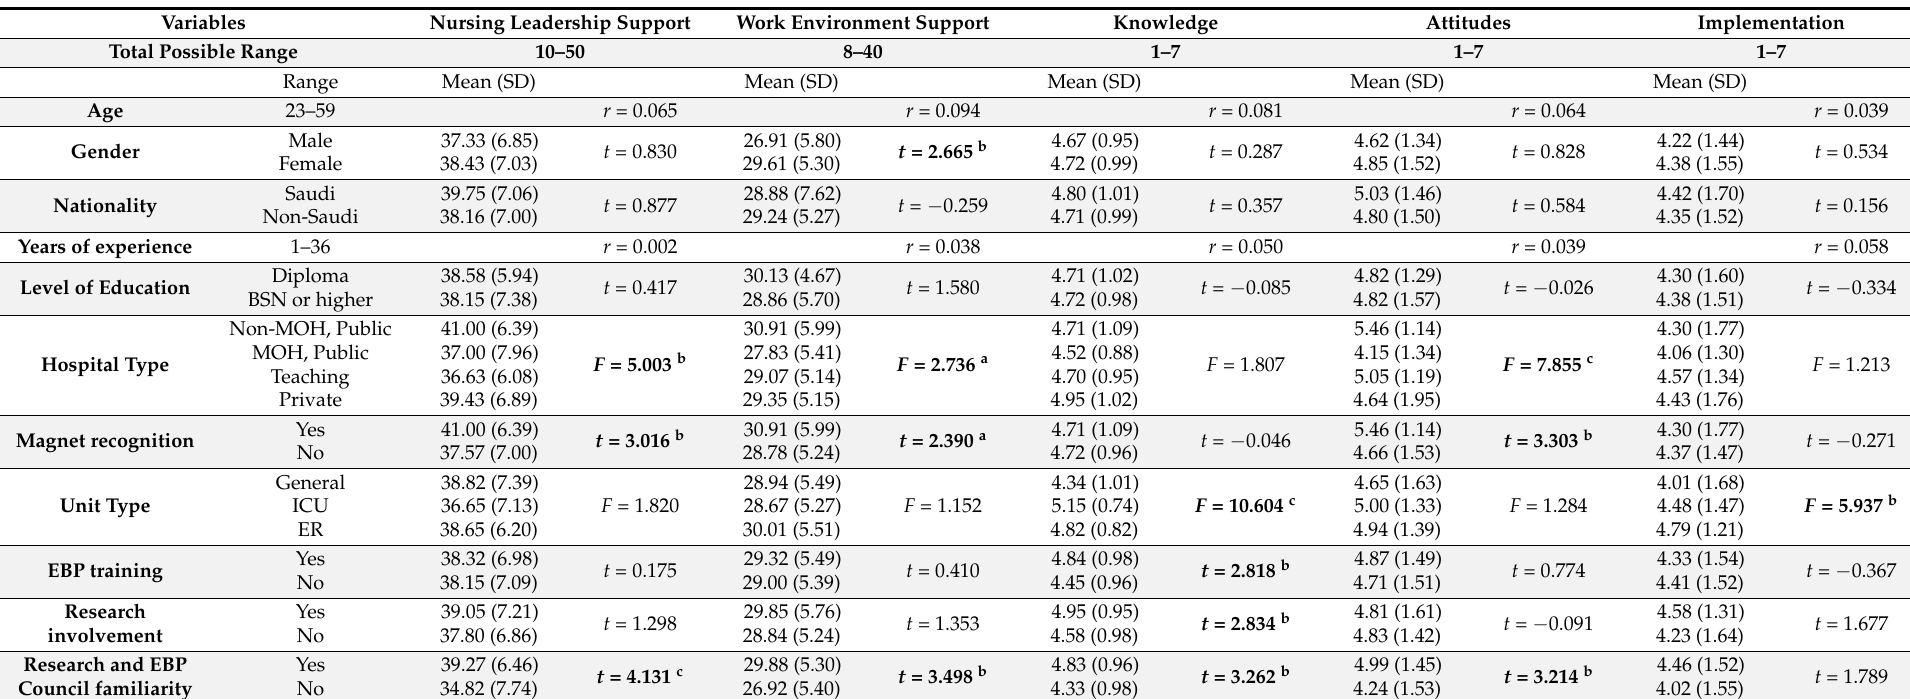
Table 3. Differences in perceived nursing leadership and work environment support, knowledge, attitude, and implementation regarding EBP by sample characteristics and organizational factors (N =